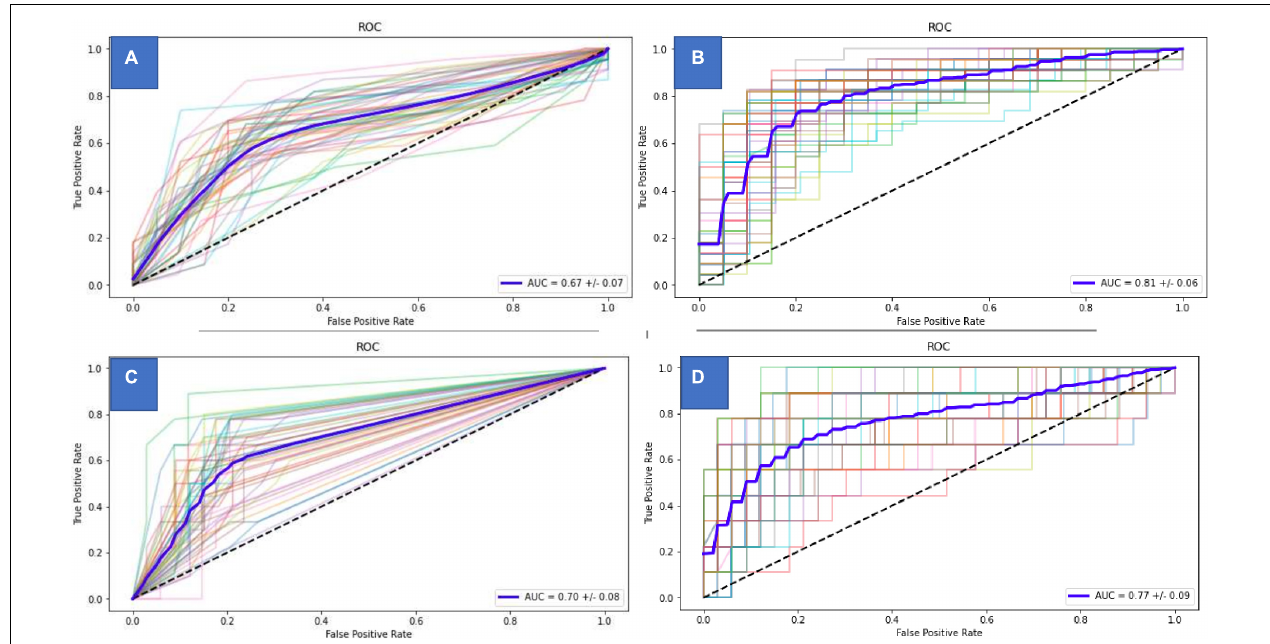
FIGURE 1 | Area under the curve of the different predictive models. (A) Delivery within one week predictive model (basal). (B) Delivery within one week predictive model (at diagnosis). (C) HELLP/Abruptio predictive model (basal). (D) HELLP/Abruptio predictive model (at